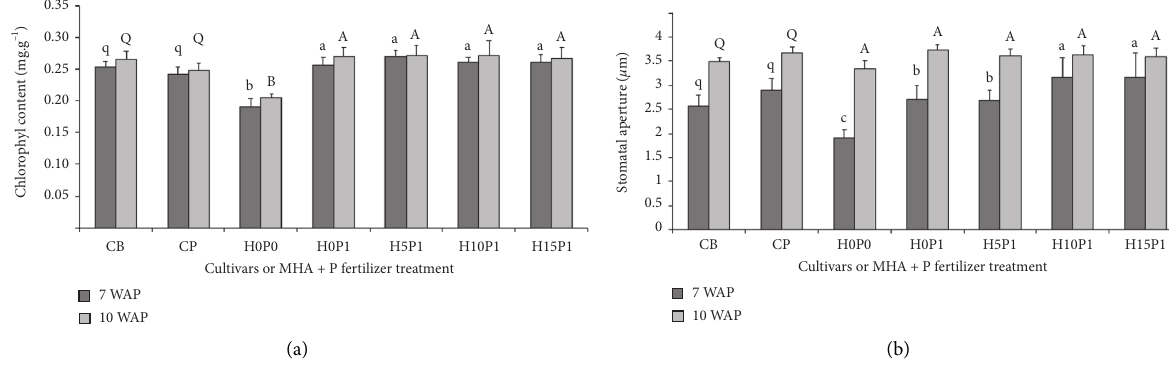
Figure 2: Chlorophyll content (a) and stomatal apertures (b) of corn 7 and 10 weeks after planting (WAP). CB is Bisi 2 hybrid corn, CP is Pioneer 35 hybrid corn. H 0 P 0 is the control, H 0 P 1 is 0mg kg − 1 composted manure (MHA)+P fertilizer, H 5 P 1 is combined 35mg kg −